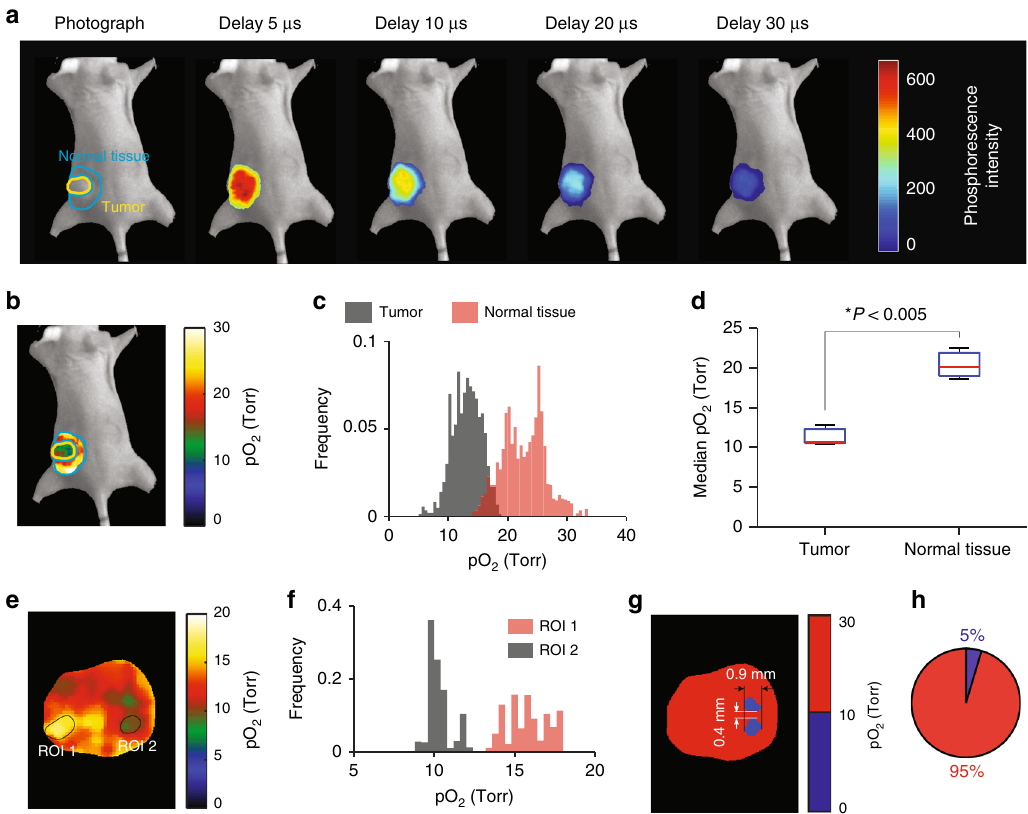
Fig. 4 In vivo imaging of pO 2 in mice 24 h after IV injection of Oxyphor PtG4. a Phosphorescence intensity images acquired at different delays of 5, 10, 20, and 30 µ s relative to the excitation pulse, overlaid with a photograph of the mouse. The regions corresponding to the tumor and the normal surrounding tissue are shown by the yellow and blue circles in the fi rst image. b Tissue pO 2 map. c pO 2 histograms. d Median pO 2 values in the tumor and surrounding tissue ( n = 3). Boxplot shows median and interquartile range; whiskers indicate the range. Statistics was performed using two-sample t -test. e Enlarged view of the tumor region in the pO 2 image. f pO 2 histograms of sub-regions (ROIs) outlined by black curves in e . g Areas shown in blue were characterized by pO 2 < 10 Torr. h Fraction of the tumor having pO 2 < 10